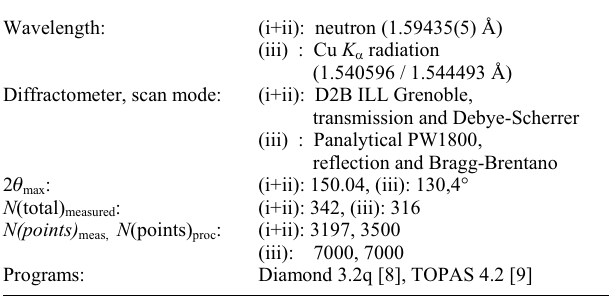
Table 1. Data collection and